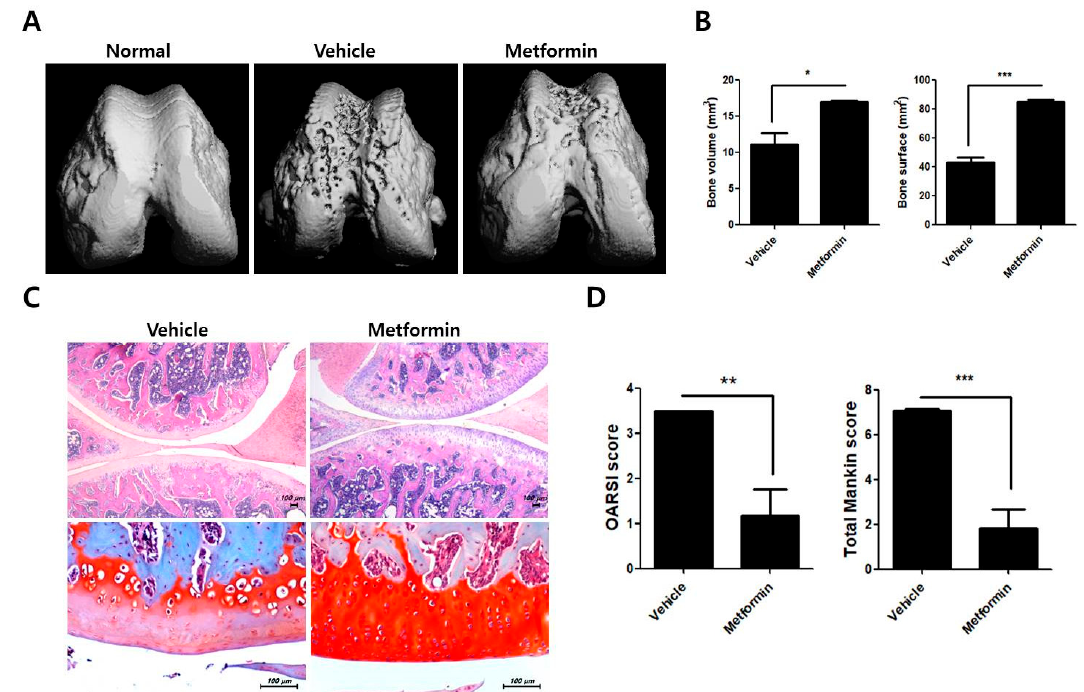
Figure 2 . Metformin ameliorates bone and cartilage erosion in MIA-induced OA rats. The rats were injected with 3 mg of MIA. After OA induction, the rats were administrated with metformin 100 mg/kg (N = 6 animals per group). The rats were sacrificed at Day 15 after OA induction to collect joint tissues. ( A ) Twenty cylindrical bone samples were obtained from bone biopsies of 20 dry hemimandibles. The samples of six animals per group were scanned using microcomputed tomography (mCT 35; SCANCO Medical, Zurich, Switzerland). ( B ) Bone volume and bone surface were analyzed using NRecon software. ( C ) Knee-joint tissue samples were acquired from all OA groups at 2 weeks and stained with hematoxylin and eosin (H&E) and safranin O ( D ) to determine Osteoarthritis Research Society International (OARSI) and Mankin scores. Data are represented as the mean ± SEM of three independent experiments (* p < 0.05, ** p < 0.01, *** p < 0.001).